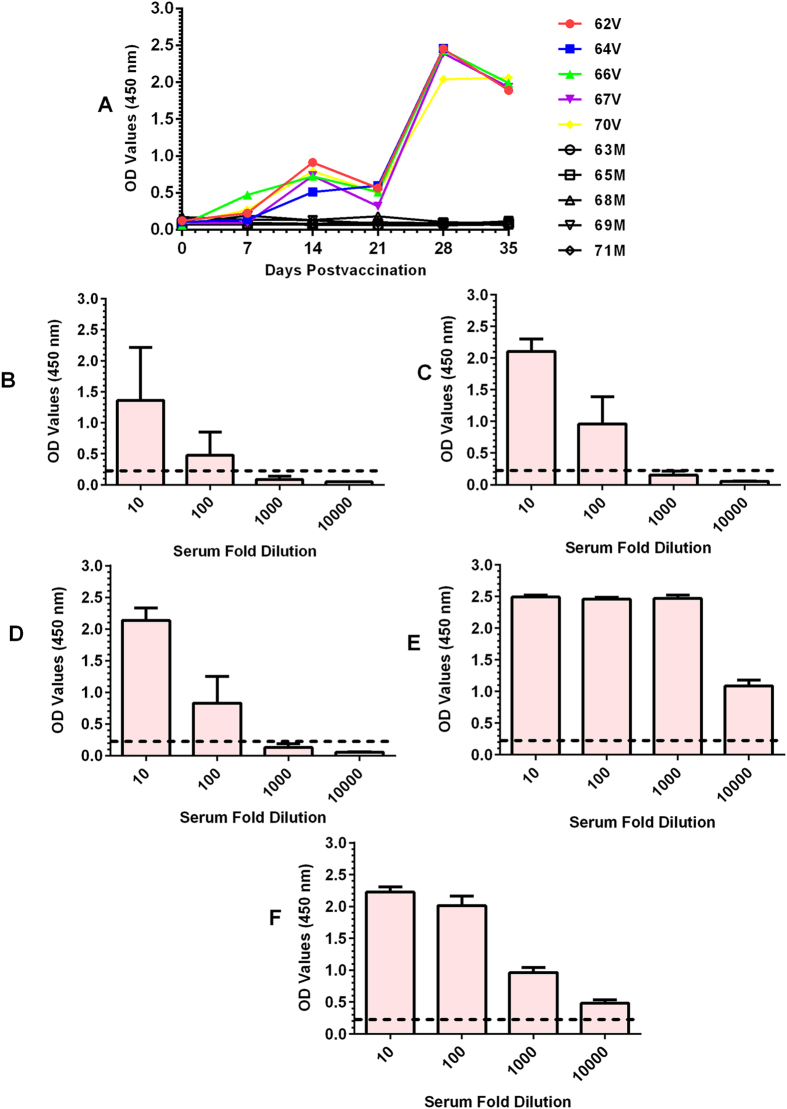
Vaccine-induced immunoglobulin G (IgG) host antibody response demonstrated by antigen-specific (Gn) indirect enzyme-linked immunosorbent assay (ELISA).(A) Shows kinetics of Gn-specific IgG antibody response in vaccinated (V) mock-vaccinated (C) sheep. The cut-off value for individual sheep: Vaccinated sheep (#62 = 0.266; #64 = 0.116; #66 = 0.083; #67 = 0.101; #70 = 0.082); Mock sheep (#63 = 0.085; #65 = 0.106; #68 = 0.286; #69 = 0.092; #71 = 0.180). Only vaccinated sheep exhibited seroconversion in response to the vaccination. Panel below shows endpoint titers for Gn-ELISA for each time point post vaccination; (B) = endpoint titer for 7 dpv; (C) = endpoint titer for 14 dpv; (D) = endpoint titer for 21 dpv; (E) = endpoint titer for 28 dpv; (F) = endpoint titer for 35 dpv; (-----) indicates the cut-off value (OD = 0.209).